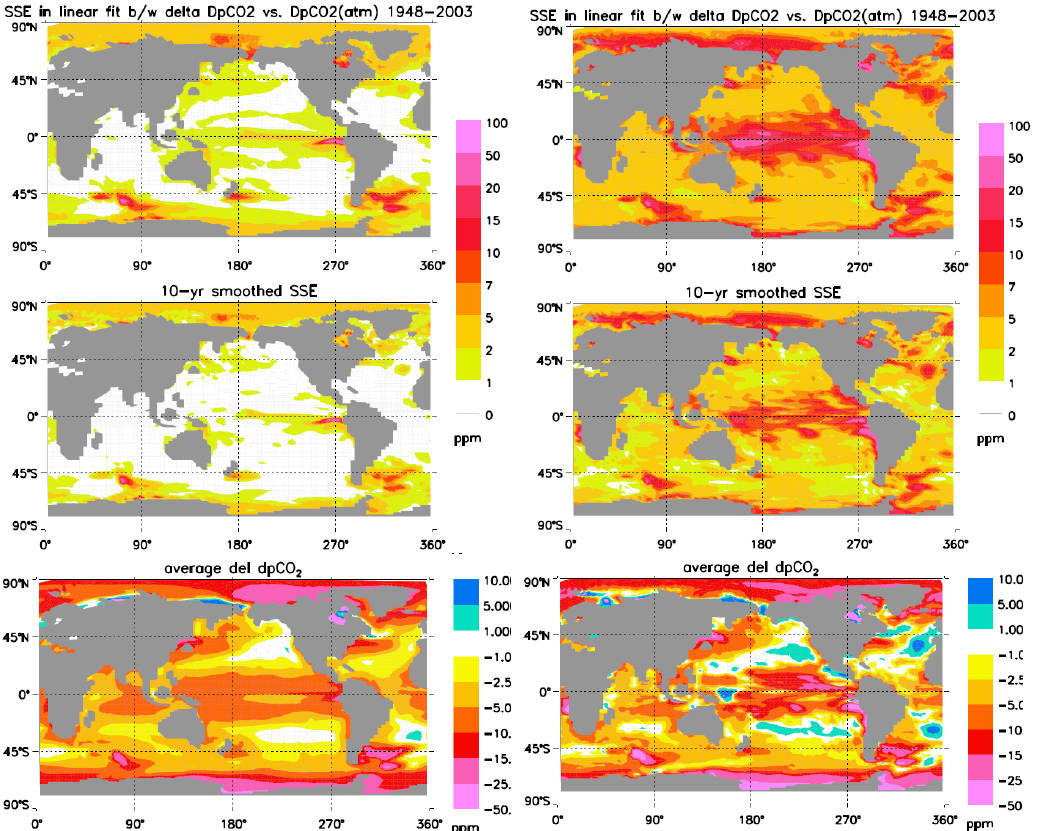
with varying climate on annual 2